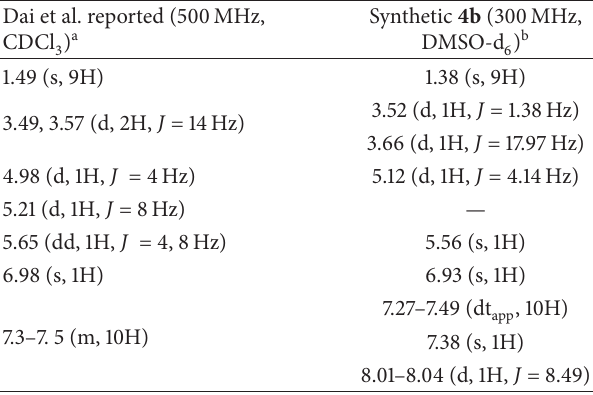
Table 4: Comparison of 13 C NMR data ( 4a ). Table 5: Comparison of 1 H NMR data ( 4b